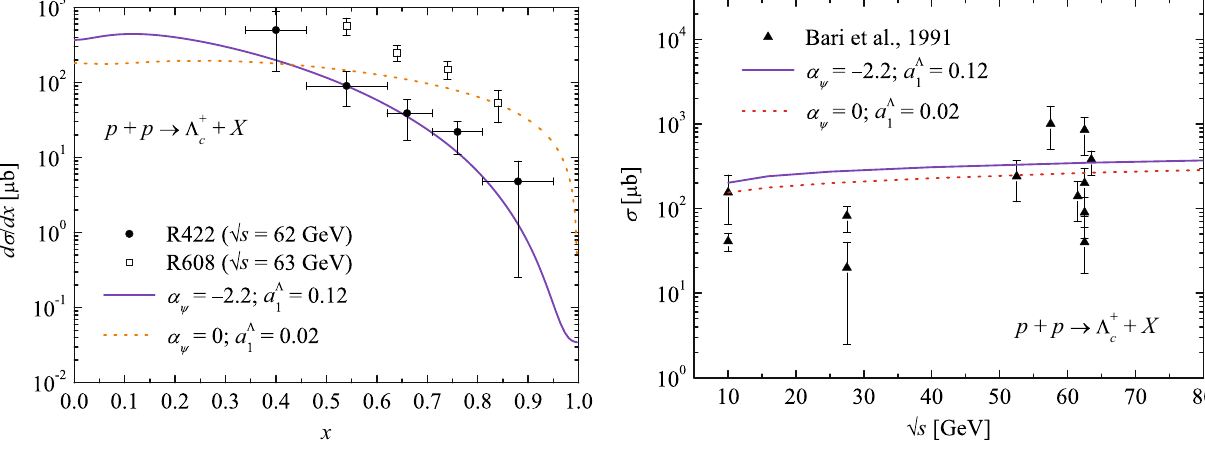
Fig. 8 Differential(left)andtotal(right)crosssectionsof (cid:2) + c baryonproductionin pp collisions:calculationsfor α ψ ( 0 ) = − 2 . 2, a (cid:2) c = 0 . 02 (dotted line). Experimental data: filled circle, filled triangle for [49]; unfilled square for line) and α ψ ( 0 ) = 0, a (cid:2) c 1